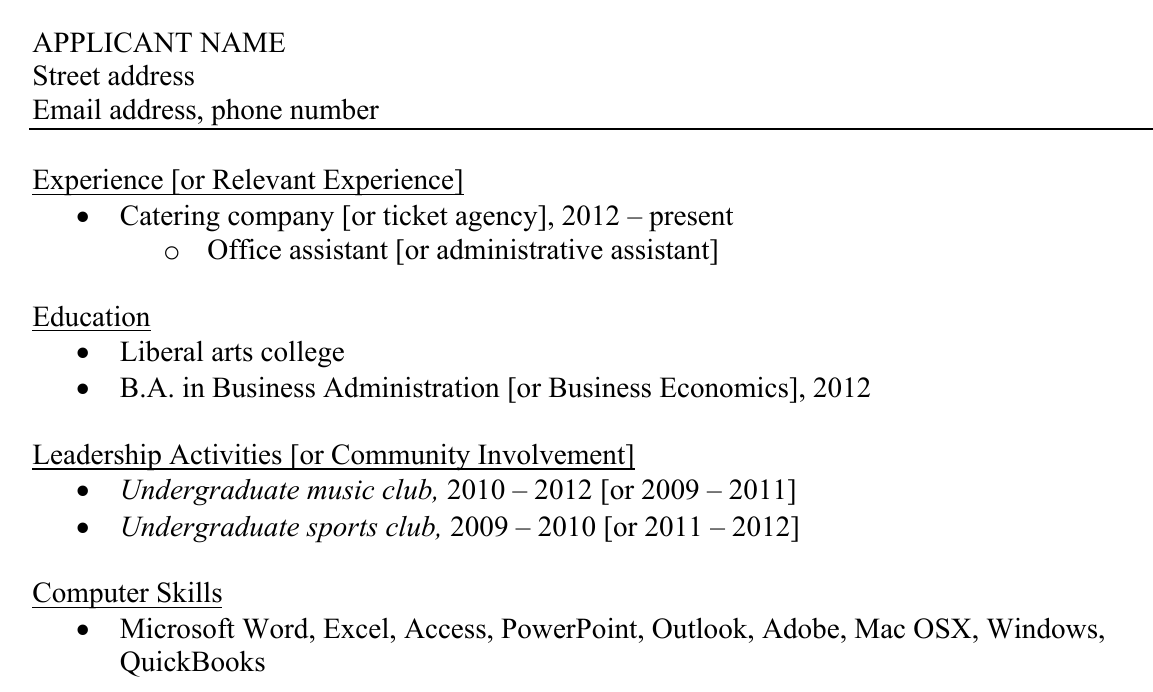
Figure 1: Résumé items. Cultural signals of class were embedded in the items listed in italics. B.A., Bachelor of Arts; Mac OSX, Macintosh Operating System